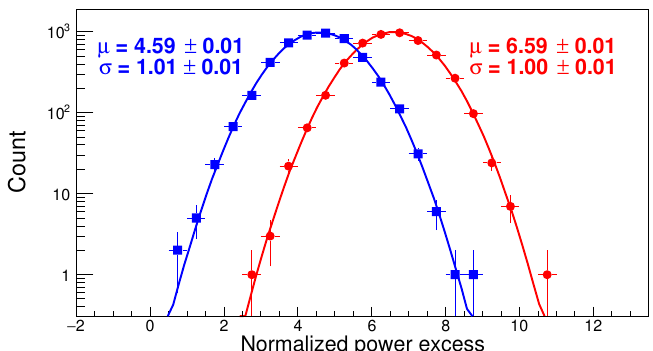
Figure 2 . Predicted SNR as a function of the number of co-adding bins. Solid (red) and dashed (blue) lines show SNRs with and without the signal weighting applied, respectively.